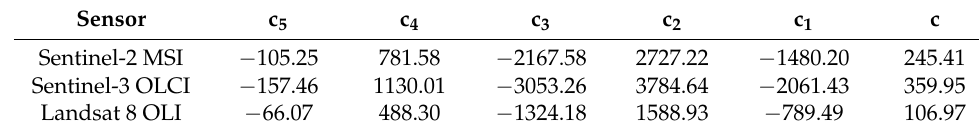
Table 3. Coefficients for correction polynomials for the Wang method.